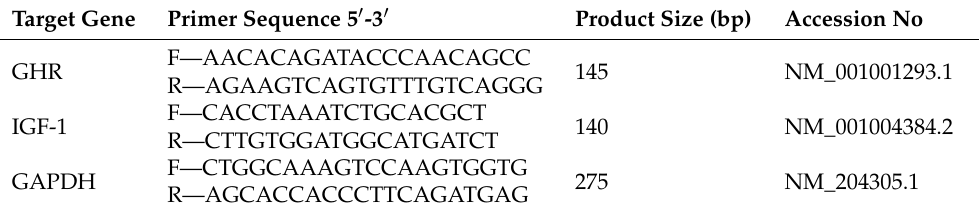
Table 3. The primer sequences for GHR, IGF-1 and GAPDH genes were used for Real Time-qPCR. Target